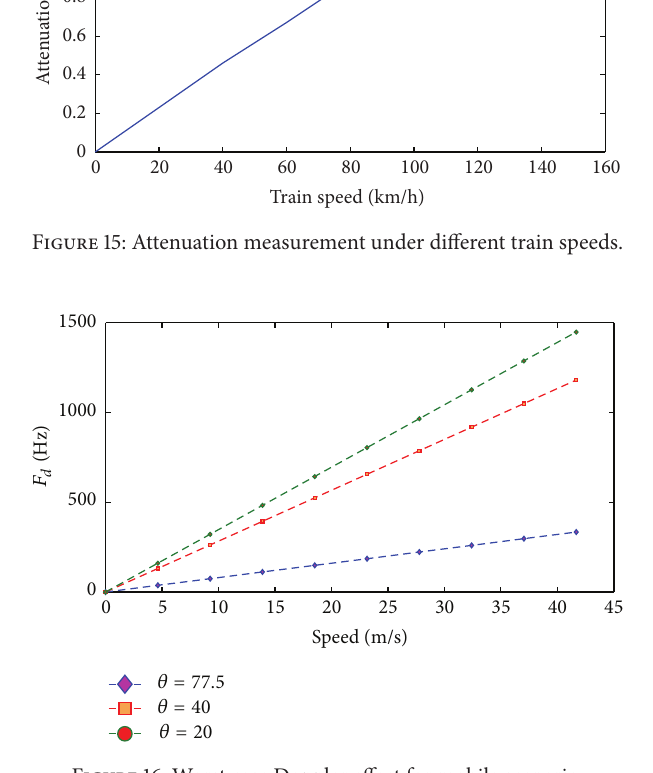
Figure 16: Worst case Doppler effect for mobile scenario.